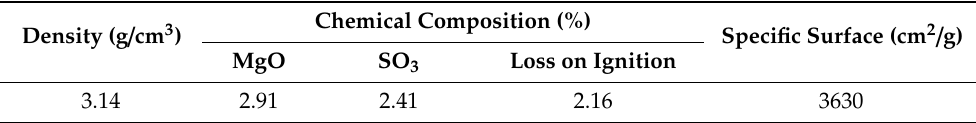
Table 1. Properties of ordinary Portland cement.